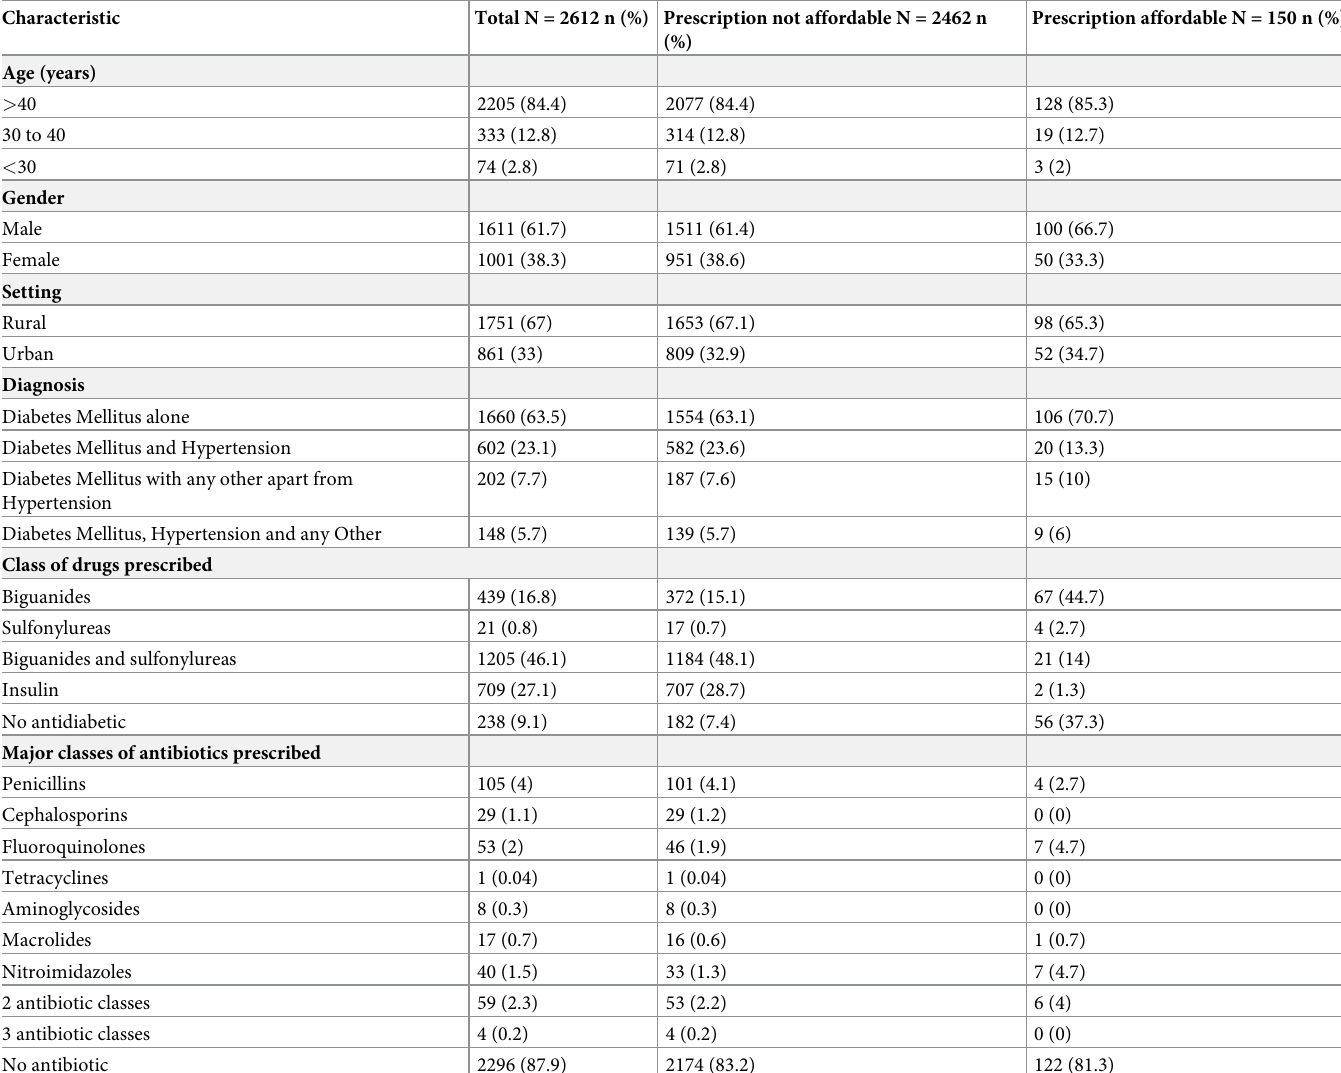
Table 1. Demographics and characteristics of prescriptions for diabetic